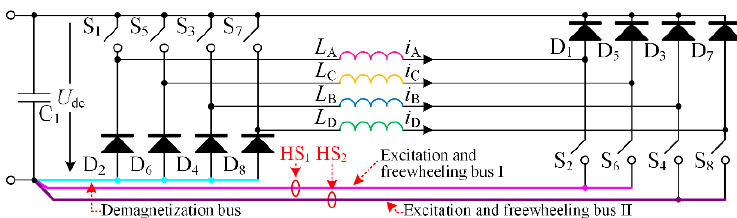
Figure 4. Modified AHBC with two current sensors for the four-phase SRM.